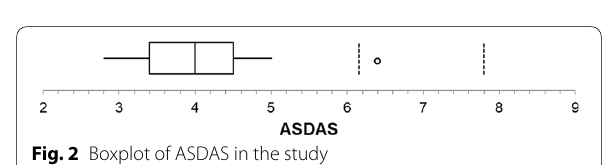
Fig. 2 Boxplot of ASDAS in the study